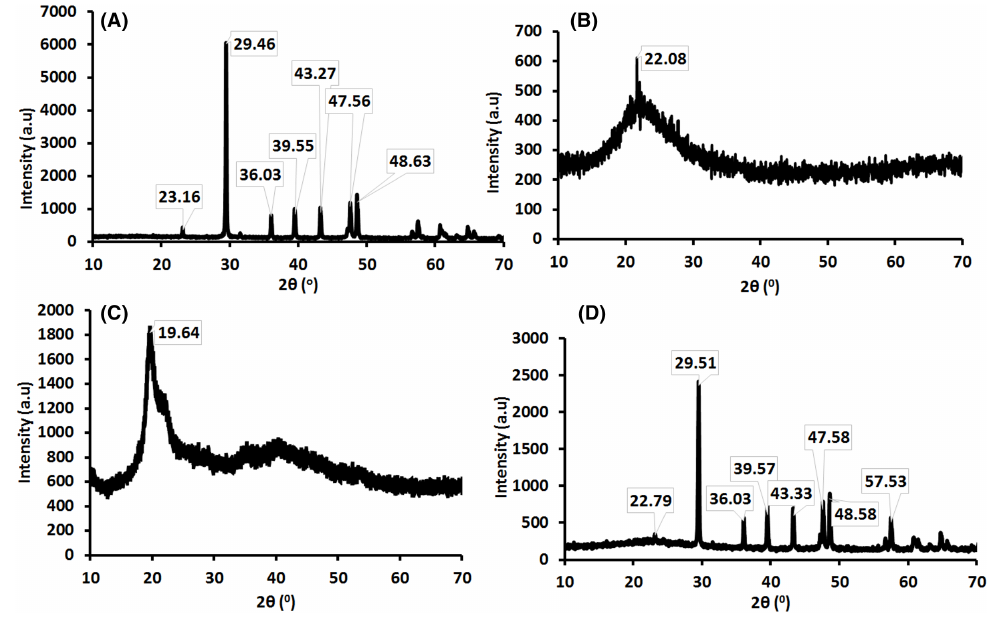
Figure 2 X-ray di ff ractogram of (A) ESCaCO 3 (B) RHSiO 2 (C) CS and (D) CS – SiO 2 /CaCO 3